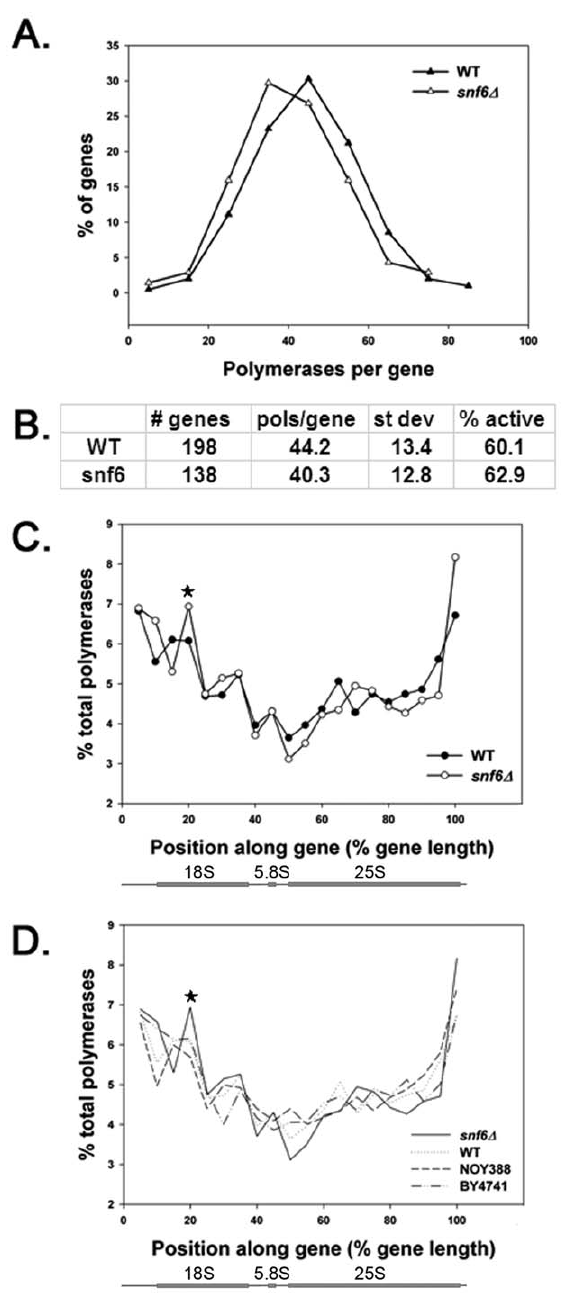
Figure 5. A small accumulation of Pol I complexes in the 5 9 end of rDNA in snf6 D . (A) Distribution frequency for the number of polymerases per gene was revealed by EM analysis of Miller chromatin spreads in snf6 D (DAS647) and WT (DAS648). (B) More than 100 rDNA genes from Miller chromatin spreads were analyzed in WT and snf6 D . Pol I density and percentage of actively transcribed genes in snf6 D and WT are similar. (C) Polymerase occupancy as a function of position within the transcribed region of rDNA in snf6 D and WT cells. A small peak of Pol I occupancy in the 5 9 end of rDNA in snf6 D is indicated by an asterisk. All mappable genes in the dataset were analyzed, corresponding to . 60 genes per strain and . 2500 polymerases per strain. Schematic below the X-axis represents the Pol I transcribed region of the rDNA. (D) Same as C but an additional two WT control strains (NOY388 and BY4741) are plotted. BY4741 data are from El Hage et al. 2010 [34].